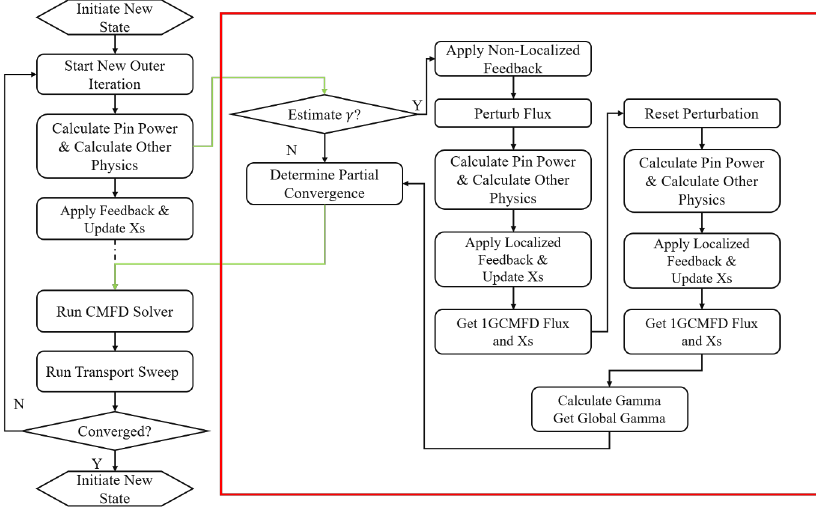
Figure 1: Flowchart of Multiphysics Scheme with Near Partially Convergent